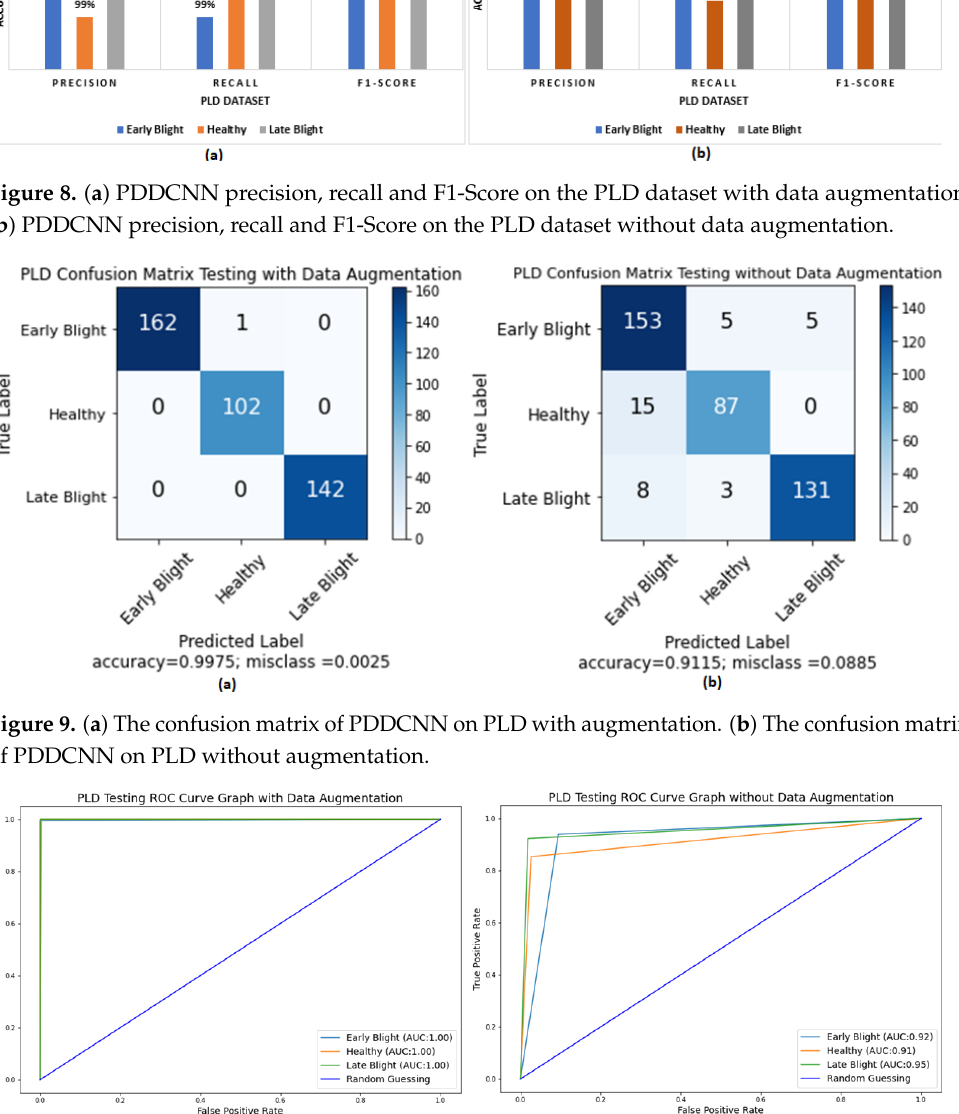
Figure 10. ( a ) ROC curve on the PLD dataset with augmentation techniques. ( b ) ROC curve on the PLD dataset without augmentation